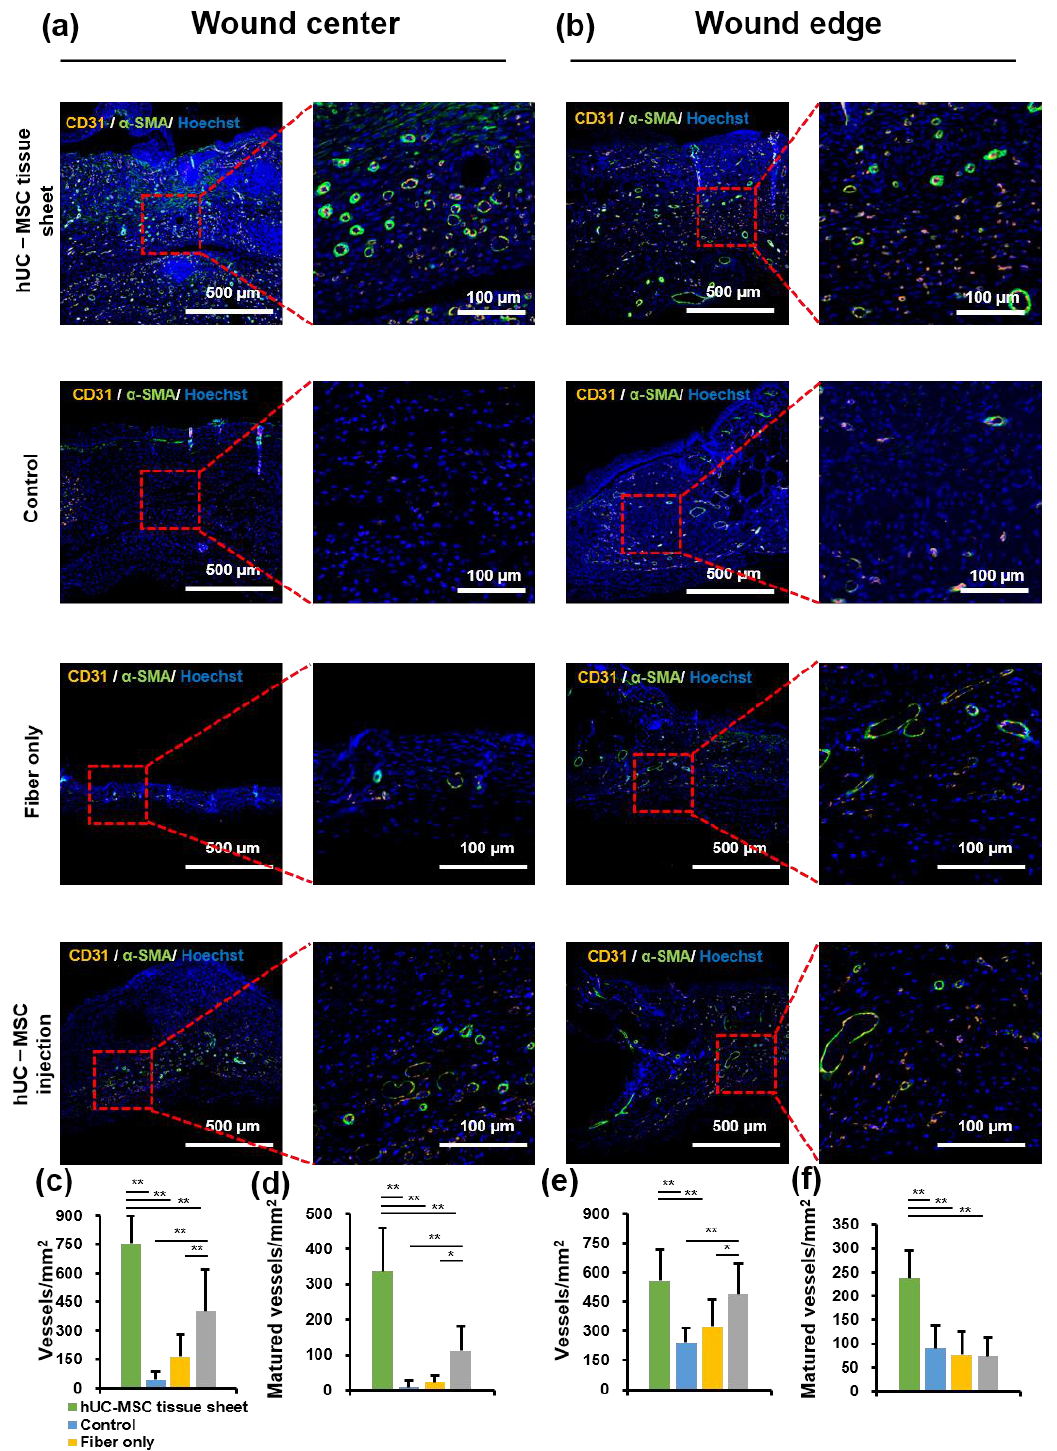
Figure 5. Human umbilical cord mesenchymal stem cell (hUC-MSC) tissue sheet remarkably pro- motes new blood vessel formation and maturation in diabetic wounds. ( a ) Representative images of tissue sections from the center of the diabetic wound area 14 days after wounding (scale bar = 500 μm and 100 μm). ( b ) Representative images of tissue sections from the edge of the diabetic wound area on day 14 after wounding (scale bar = 500 μm and 100 μm). ( c ) Quantitative analysis of vessel density of wound center in different groups 14 days after wounding. ( d ) Quantitative analysis of matured vessel density of wound center in different groups 14 days after wounding. ( e ) Quantitative